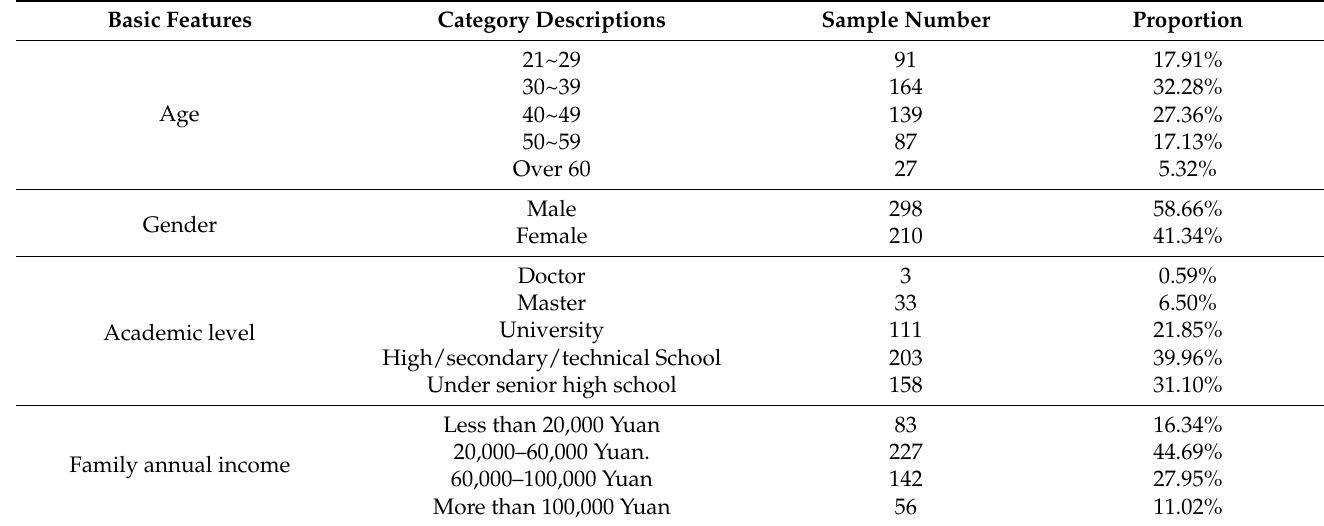
Table 2. Demographic characteristics of